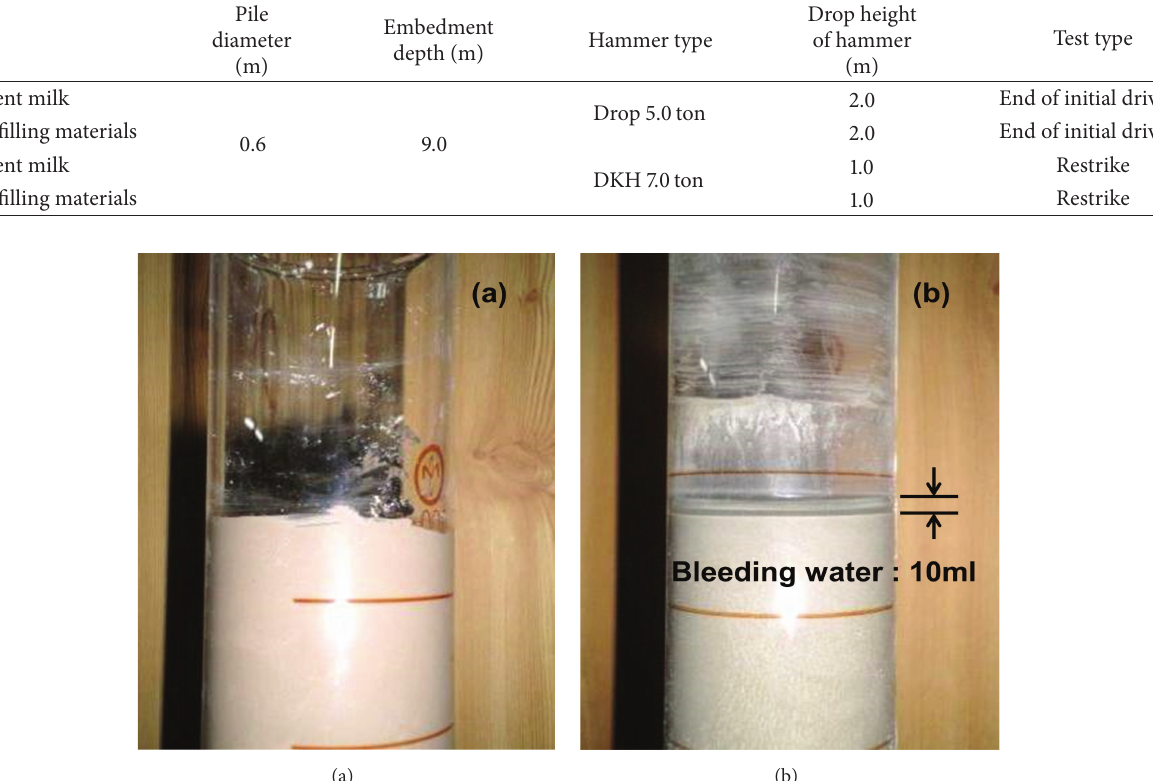
Figure 6: Bleeding of the new filling material (a) and cement milk (b).